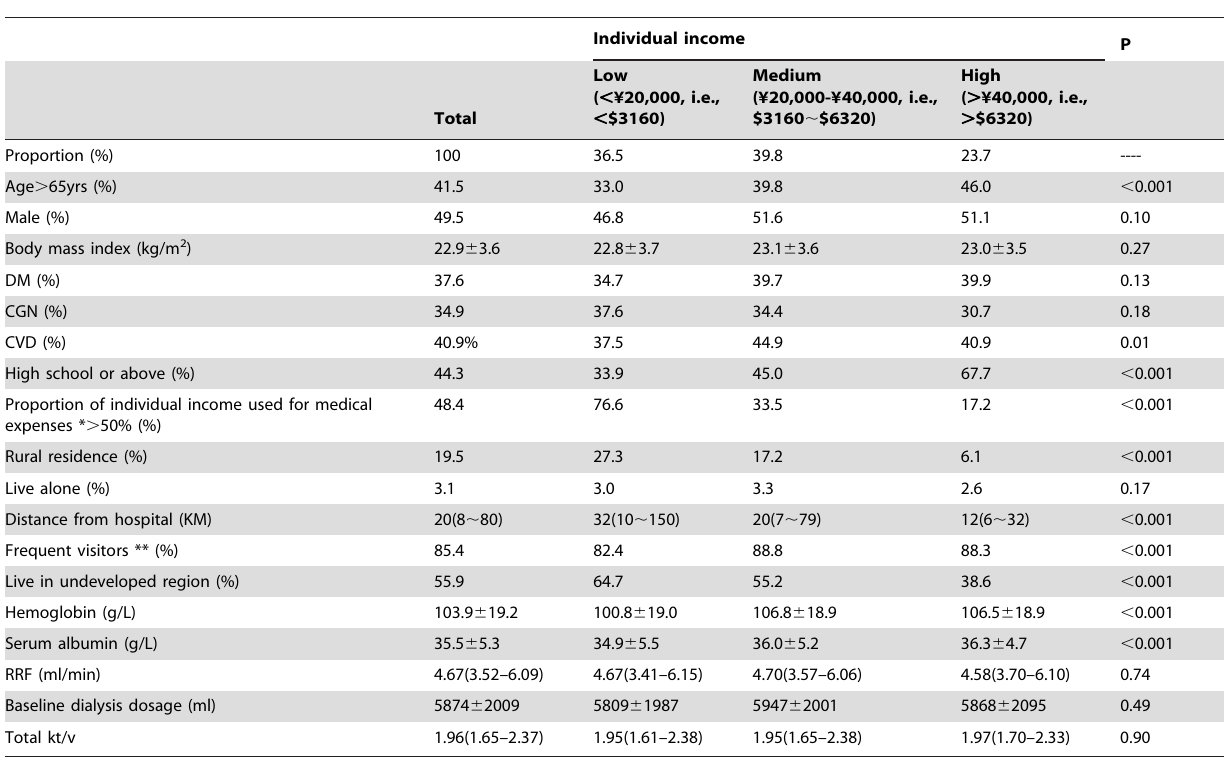
Table 1. Baseline characteristics according to individual